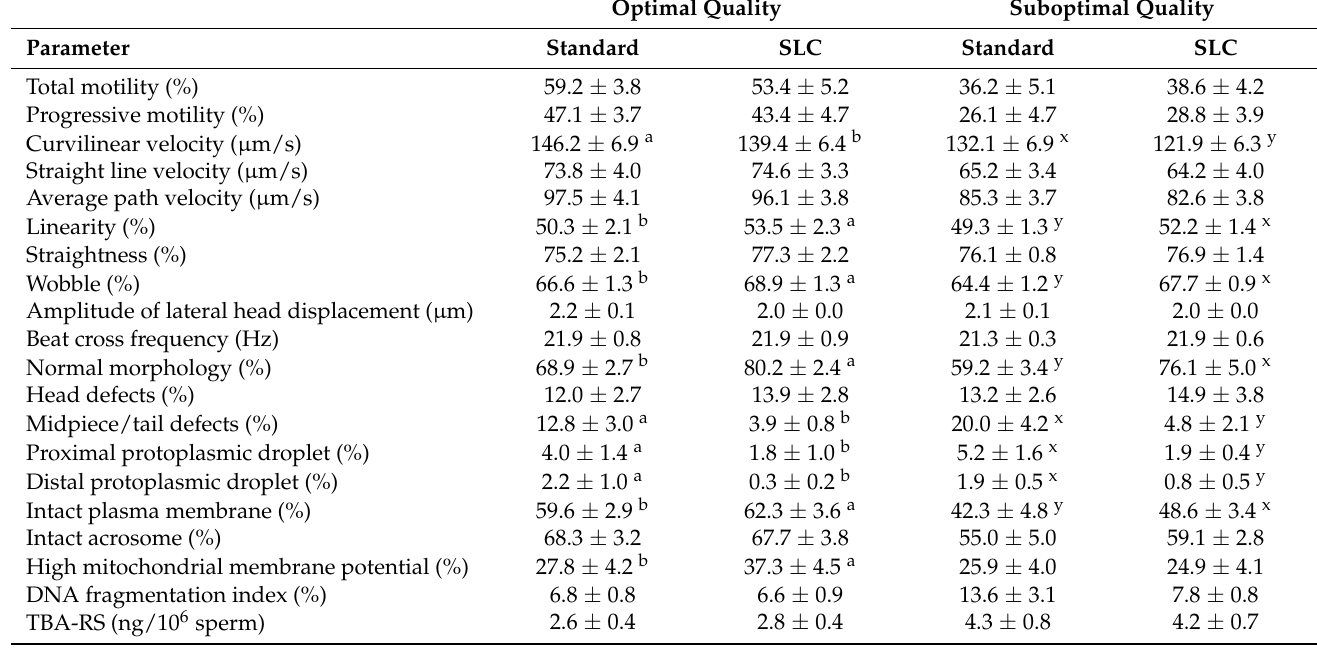
Table 3. Post-thawed semen parameters (mean ± SEM) of optimal quality ejaculates (normal morphol- ogy ≥ 80%) and suboptimal quality ejaculates (normal morphology between 60 and 79%). Samples were cryopreserved after standard centrifugation (Standard) or single-layer centrifugation